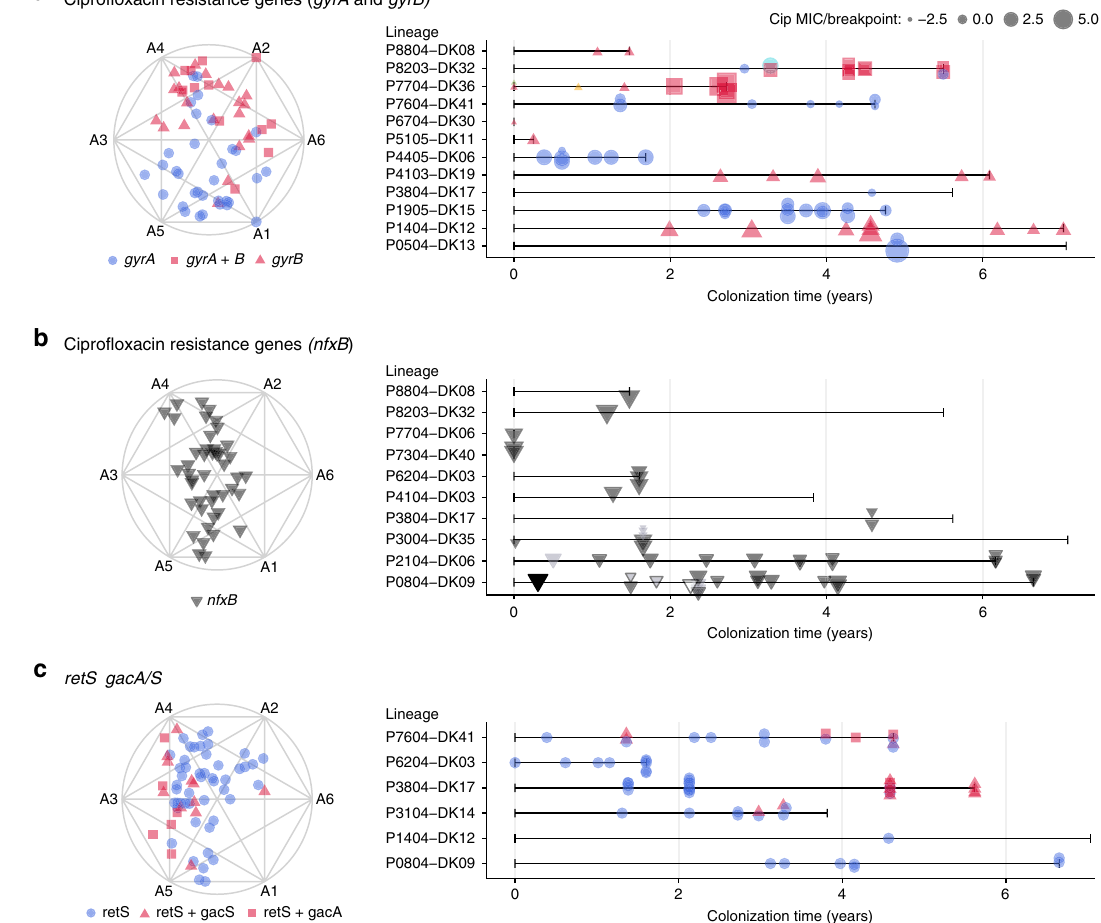
Fig. 5 Mechanistic links, gyrA/gyrB/nfxB and retS/gacAS/rsmA . We use AA to illustrate phenotypic separation by isolates affected by distinct mutations in cipro fl oxacin resistance genes gyrA , gyrB , and nfxB and the retS/gacAS/rsmA regulatory system. ( a , b , left panel) As visualized by AA simplex plots, the diversity of trait pro fi les associated with isolates with mutations in DNA gyrase ( gyrA/B ) is in stark contrast to the constrained band of nfxB -mutated isolates. Mutations in DNA gyrase and nfxB do not co-occur in the same isolate but co-occur in different isolates of two lineages (patient P8804, genotype DK08 and patient P8203, genotype DK32). The differences in time of appearance during the colonization period and persistence of gyrA / B mutant isolates versus nfxB mutant isolates is shown in the lineage timelines plotted in the right column for gyrA/B ( a , right panel) versus nfxB ( b , right panel). Furthermore, gyrB -mutated isolates cluster more closely with A2 and A4 than gyrA mutated isolates, indicating a potential association with adhesion; GAMM predicts that gyrB mutation has a signi fi cant impact on adhesion ( p -value « 0.01, GAMM with Wald-type tests). ( c , left panel) Mutations in the retS/gacAS/rsmA system show a clear phenotypic change when retS is mutated alone (blue circles) or in combination with gacA or gacS (red squares and circles). The associated lineage plot ( c , right panel) shows the appearance of double mutations ( retS + gacA/S ) after a colonization period by retS mutated isolates in three patient lineages. ( a/b/c – lineage plot notation) Multiple isolates may be collected at the same sampling date based on differences in colony morphology or collected from different sinuses at sinus surgery, which explains the vertical overlap of isolates for some lineages. Lineage length is based on the span of time for which we have collected isolates and is indicated by gray bracketed lines, with only isolates affected by a mutation of the gene of interest plotted using shape and color (see legend of simplex plots). If multiple unique mutations occur in a lineage, this is speci fi ed by differential shading. ( a/b only) Symbol size indicates the level of resistance to cipro fl